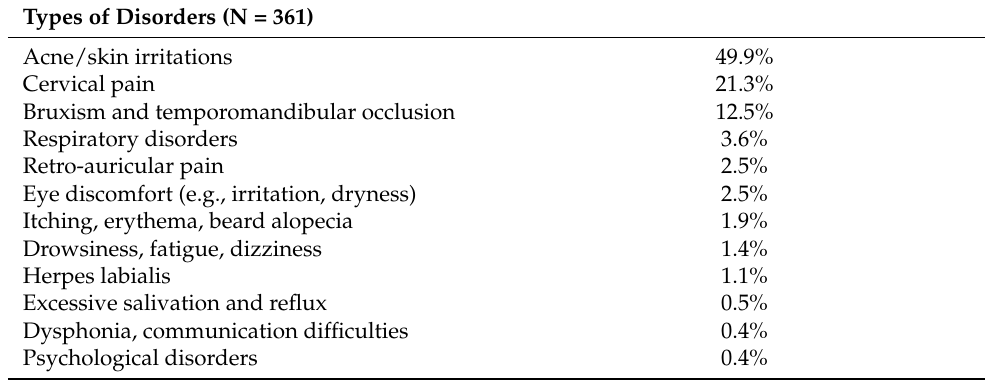
Table 2. Other discomfort resulting from the use of the